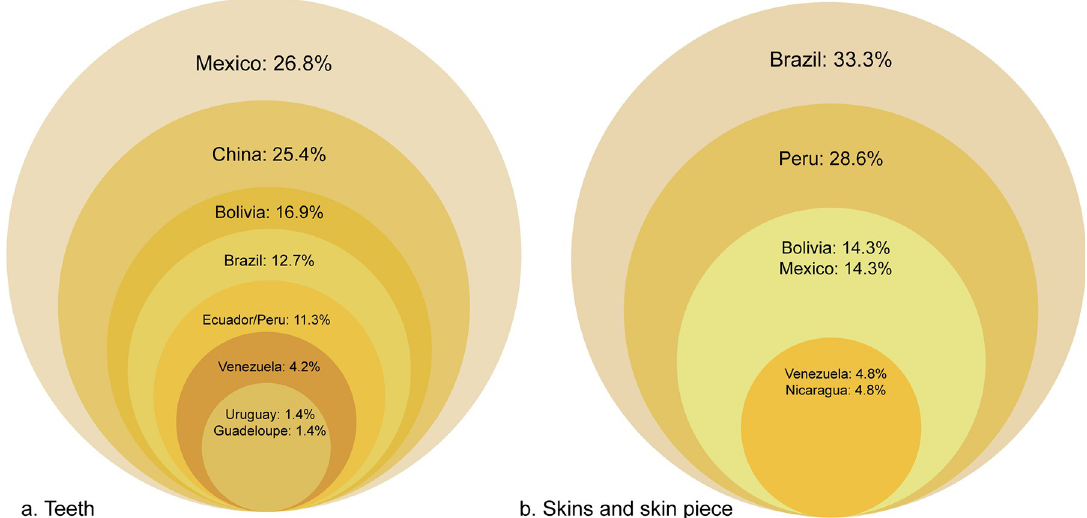
Fig 5. a. Percentage of detected jaguar teeth linked to a location in each country (n = 71). b. Percentage of detected jaguar skins and skin pieces linked to a location in each country (n = 21).